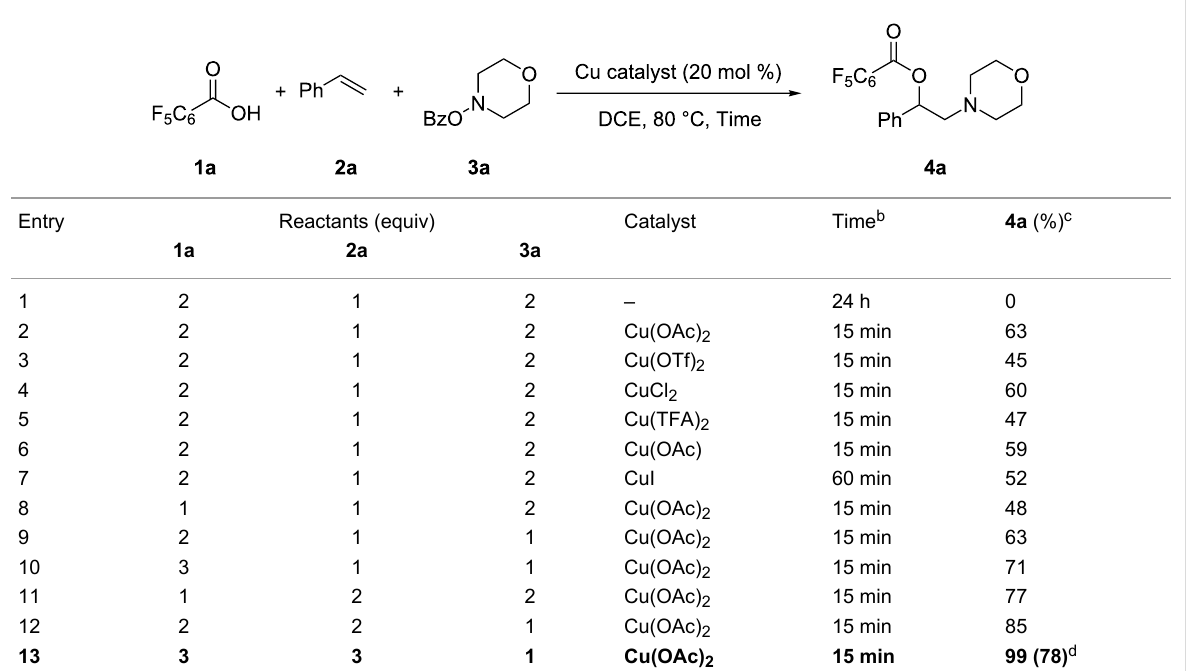
Table 1: Optimization of copper-catalyzed intermolecular oxyamination. a